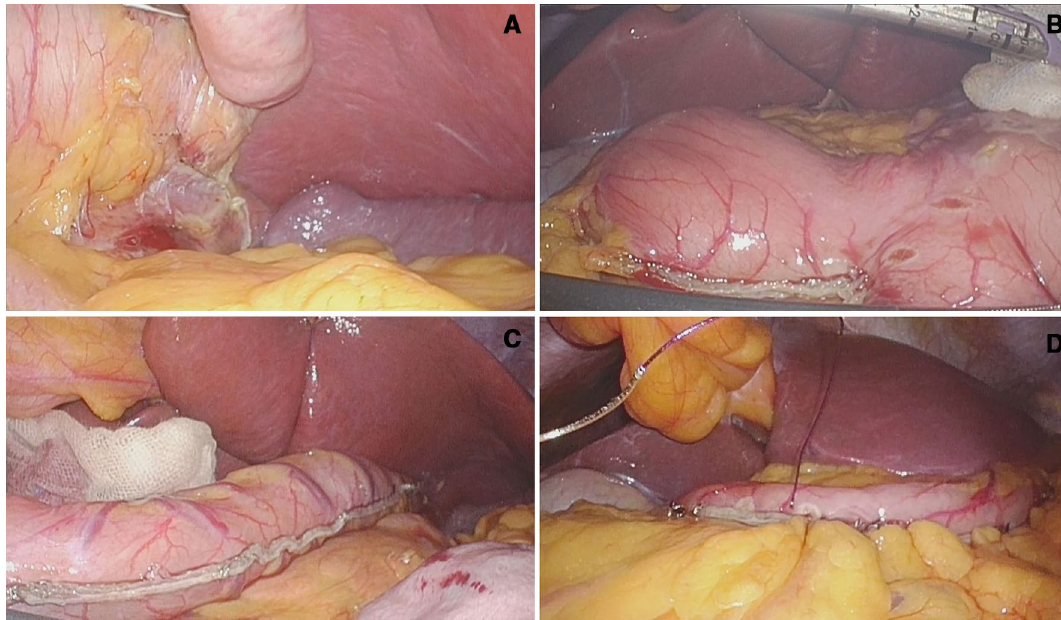
Figure 3. The laparoscopic reduced-port sleeve gastrectomy procedure. ( A ) Fundus dissection. ( B ) 1st stapling with an endoscopic stapler. ( C ) Completion of gastrectomy calibrated with a 36-Fr orogastric suction bougie. ( D ) Final view after remnant stomach was fixed to the greater